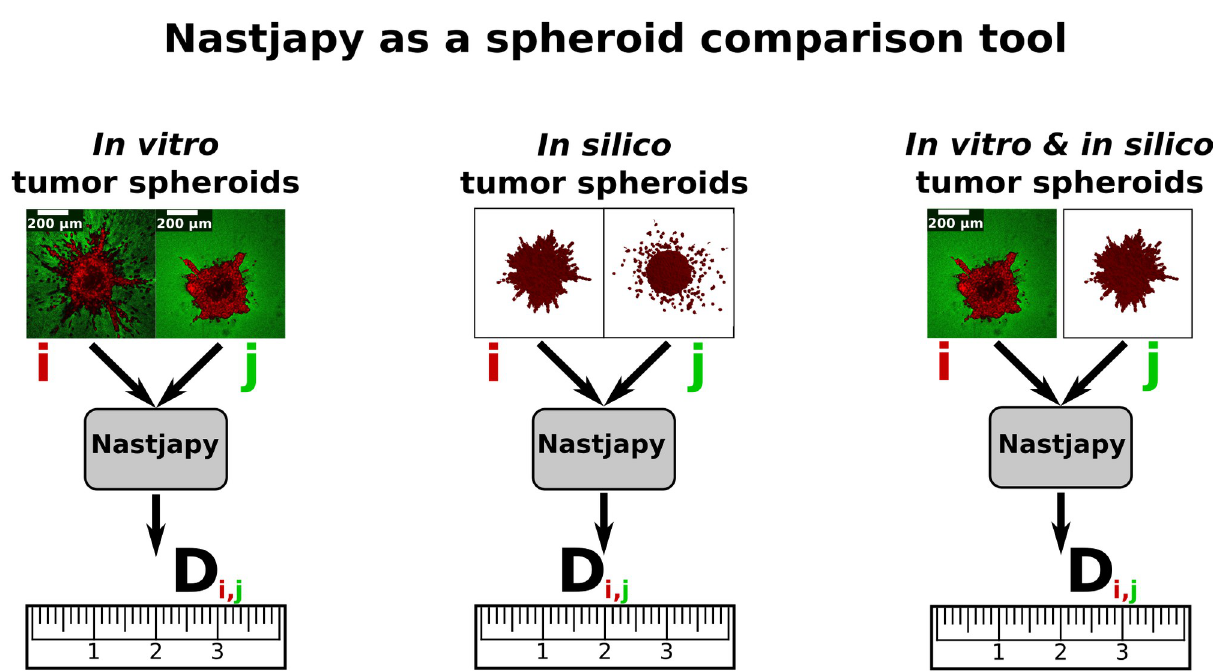
Fig 4. Sketch of the application of Nastjapy . An overall deviation score D i,j is calculated between two individual spheroids i and j (see also section 4.4).